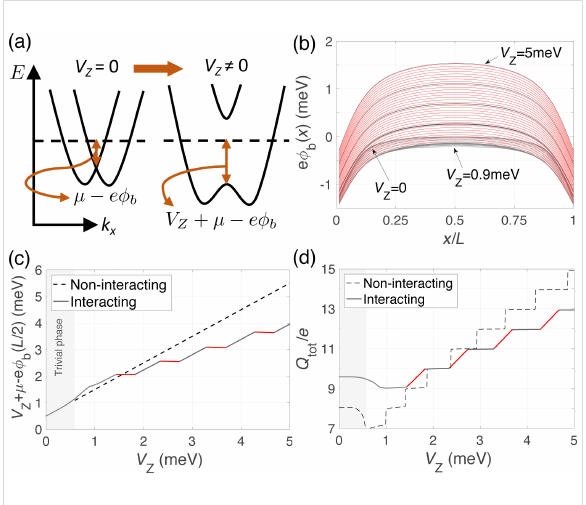
Figure 2: Majorana nanowire subject to interactions from the electro- static environment (ignoring the influence of the bulk normal leads at its ends). (a) Schematic of the dispersion relation of the nanowire in the absence and in the presence of a Zeeman field. (b) Self-consistent induced potential energy along the length of the wire for in- creasing values of the Zeeman splitting. Wire parameters as in Figure 1b and with μ = 0.5 meV. (c) Energy difference between the Fermi level and the band bottom at the center of the nanowire, V Z + μ − ( L /2), and (d) total charge Q tot of the nanowire as a function of V Z for the non-interacting (dashed) and interacting (solid line) cases. Red curves highlight parameter regions for which there is interaction-in- duced zero-energy pinning in the